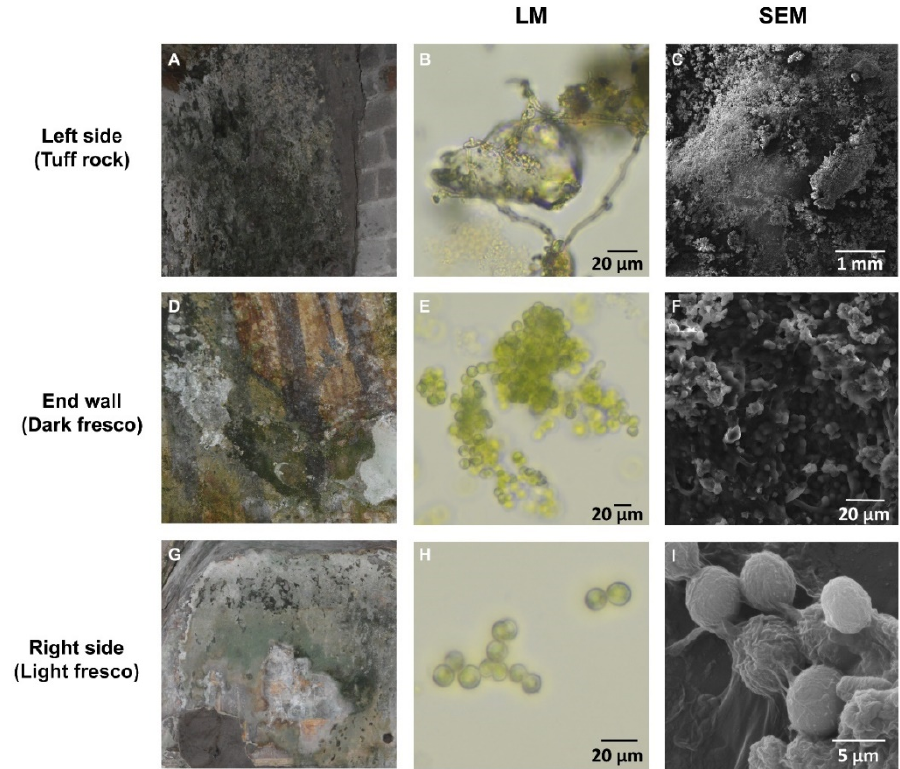
Figure 2. Photographic, light microscopy and scanning electron microscopy (SEM) images of biofilms sampled in the Fornelle cave. ( A – C ) tuff rock; ( D – F ) dark fresco; ( G – I ) light fresco.